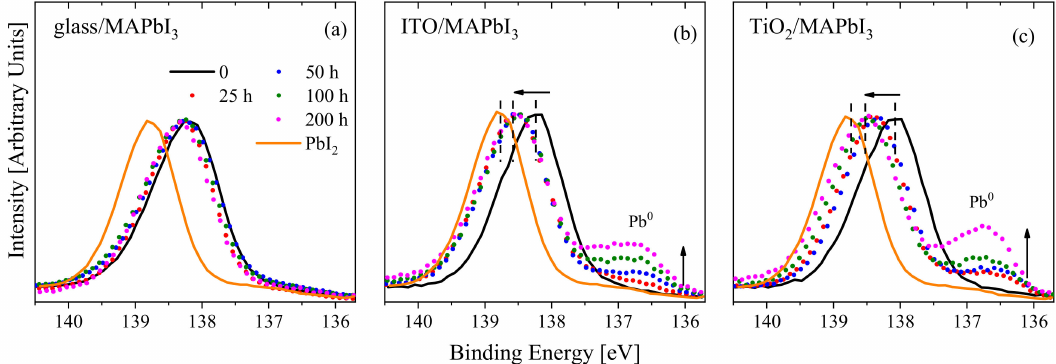
Figure 6. XPS Pb 4f 7/2 spectra of light-soaked MAPbI 3 hybrid perovskites prepared on different substrates: ( a ) glass, ( b ) ITO, and ( c ) TiO 2